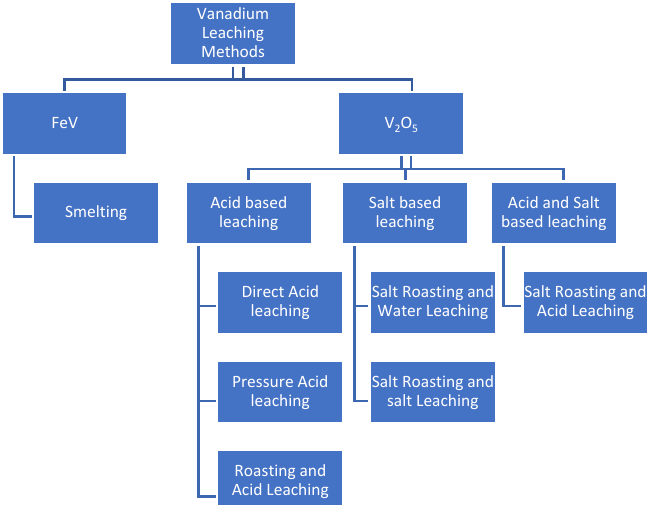
Figure 1. Methods for leaching vanadium based on the desired end product.